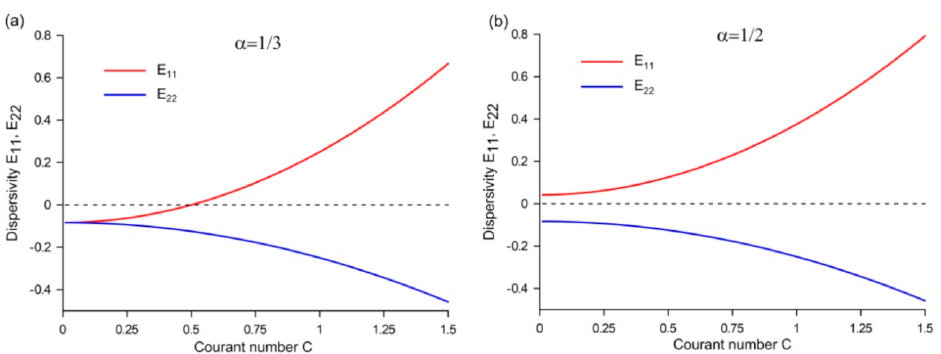
Figure 6. The values of the dispersivity tensor components E 11 and E 22 versus the Courant number C calculated using the 8N mesh structure for: ( a ) α = 1/3; ( b ) α =